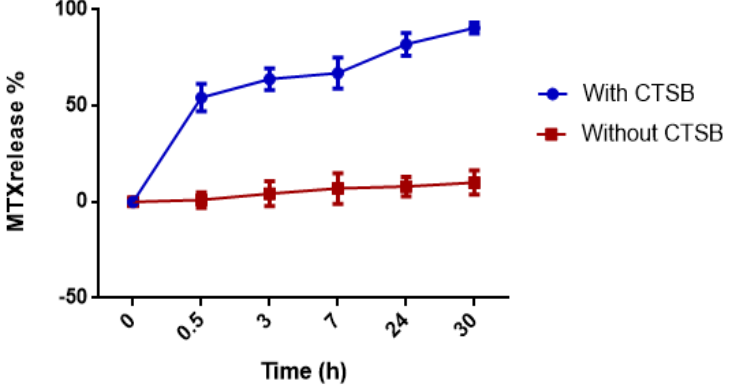
Figure 3. Time-dependent release of MTX from MTX – G – P 4 LDN – E2. The experiment was conducted